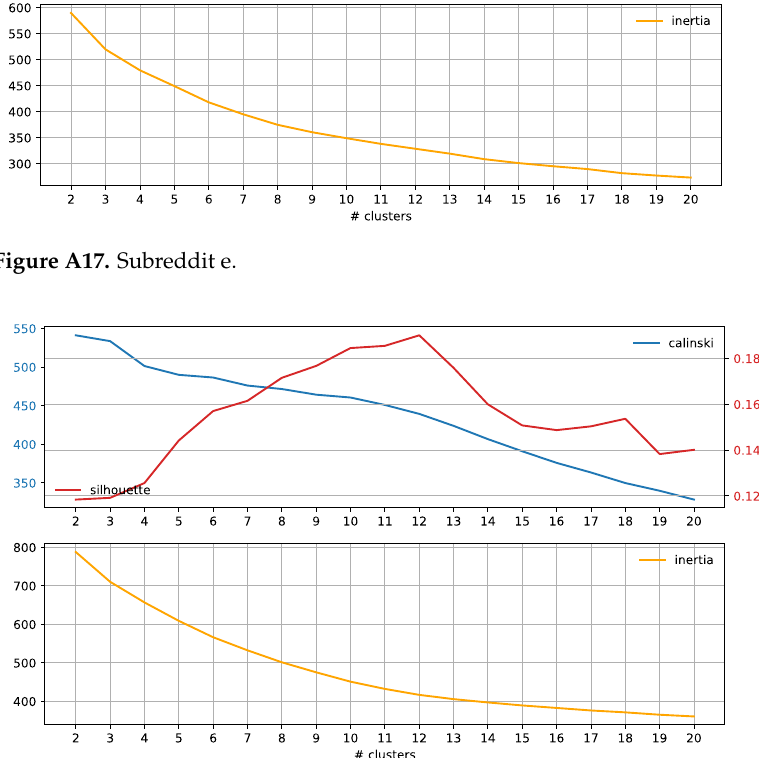
Figure A18. Subreddit e.